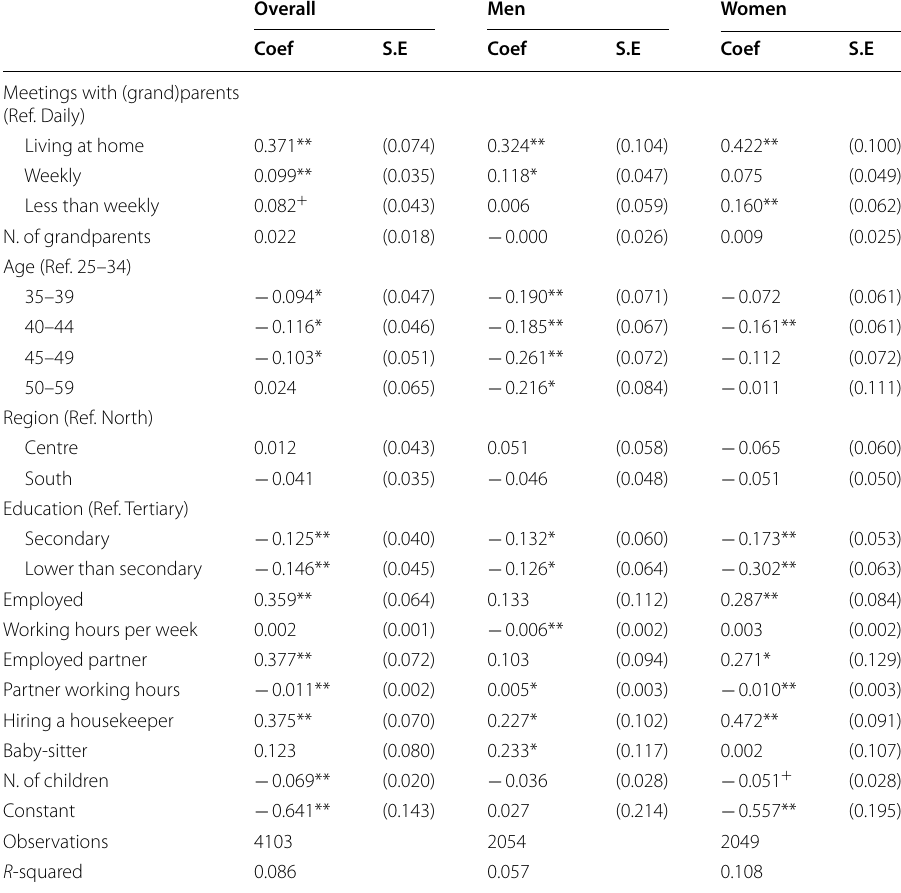
Table 9 Linear regression models on symmetry in the division of housework tasks ( Z -score). Sample of grandchildren aged